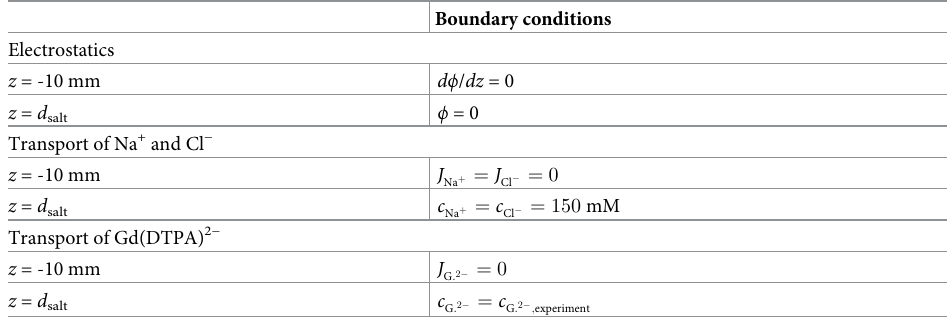
Table 2. Boundary conditions. Boundary conditions used in the finite element method (FEM)